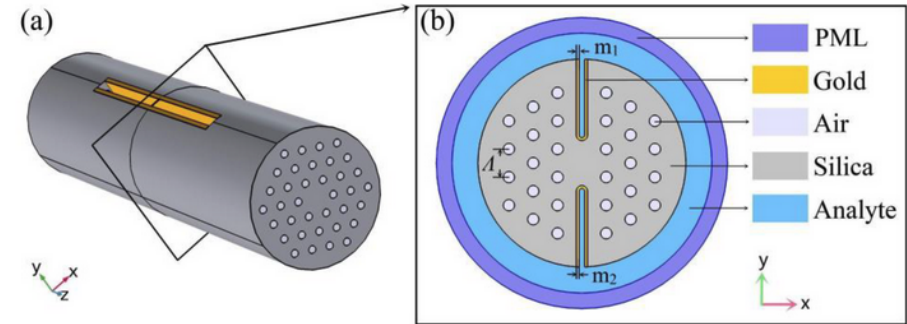
Figure 37. ( a ) H-shaped photonic crystal fiber (PCF). ( b ) Sensor coated with gold. Reprinted with permission of [106].